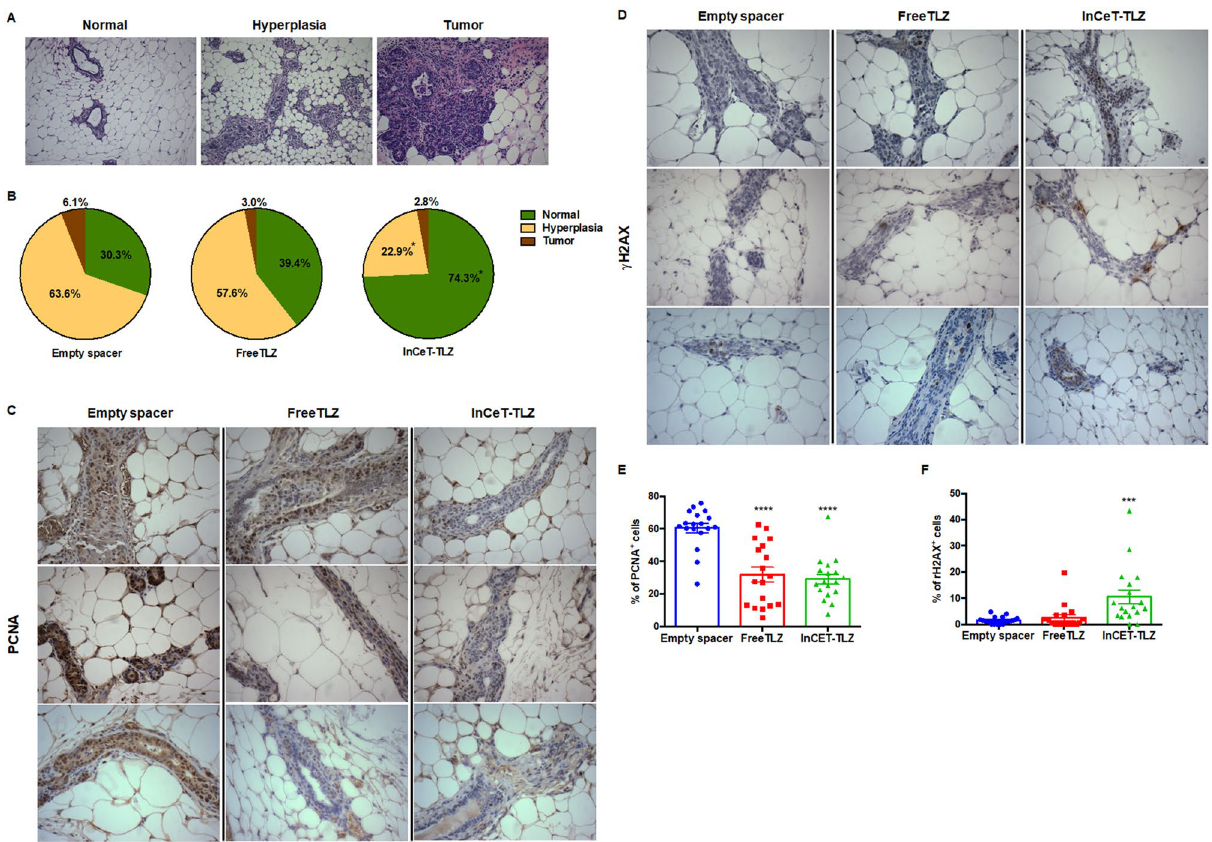
Figure 3. InCeT-TLZ prevents the development of hyperplasia in BRCA1-deficient mice. 2 mm blank implants or 2 mm InCeT-TLZ spacers were injected into the left abdominal mammary gland of Brca1 Co/Co ;MMTV- Cre;p53 +/− mice. The same amount of drug (50 μg divided into 13 doses) was given to a third group of mice by gavage as an oral delivery control group (FreeTLZ). All the mice were harvested 4 weeks after treatment, and their mammary glands were collected for analysis. ( A ) Representative H&E staining showing a normal mammary gland, hyperplasia and a mammary gland tumor. ×100 magnification. ( B ) Distribution of histopathology in each treatment group. N = 33–35 mice/group. *p < 0.05 vs. empty spacer group and FreeTLZ. ( C ) Representative pictures of PCNA expression or of γH2AX expression ( D ) in the mammary gland by IHC staining. ×400 magnification. Expression of PCNA ( E ) or γH2AX ( F ) in the mammary gland was quantified using ImageJ. N = 18 mice/group. ****p < 0.0001 vs. empty spacer; ***p < 0.001 vs. empty